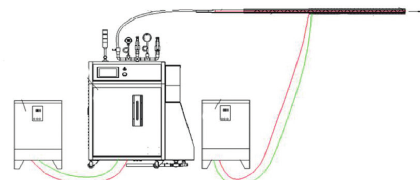
Figure 1: Ultrahigh-temperature electromagnetic heating device machine